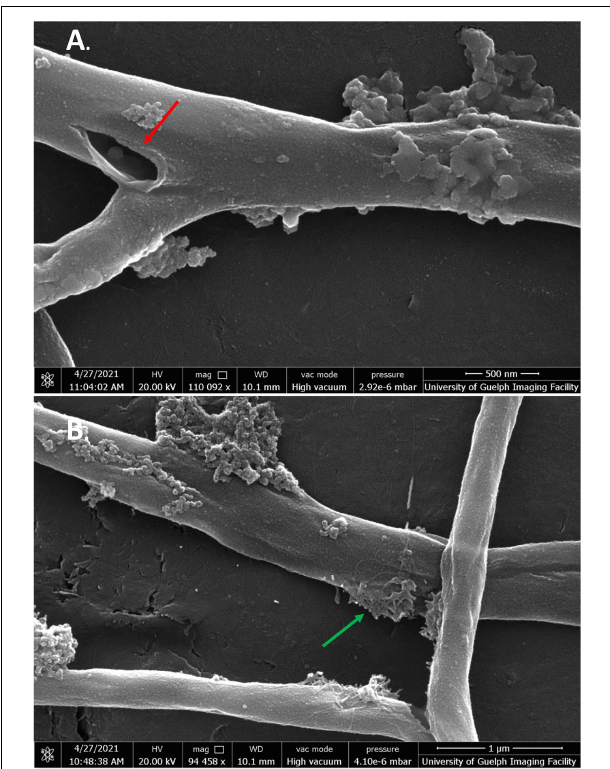
FIGURE 9 | SEM images of S. scabies grown in the presence of quercetin. (A,B) S. scabies grown overnight in nutrient broth with 4% DMSO and quercetin at 1/2 MIC concentration as well as a metal spring for shearing. The red arrow points to opening in the outer membrane. The green arrow shows an area with possible cell contents being expelled from cell. Images were taken via a Quanta 250 FEG SEM (FEI company, OR, United